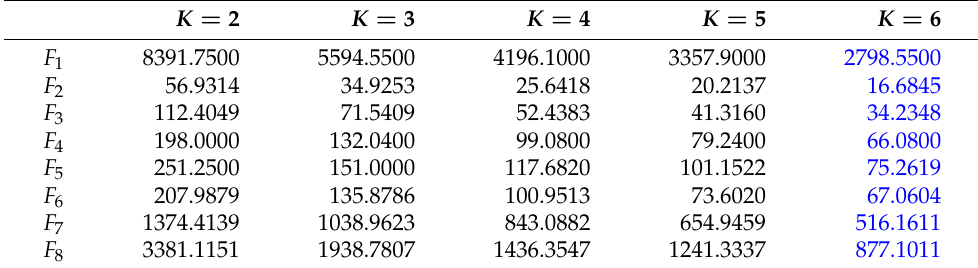
Table 2. Performance index using k-means (best values in blue).